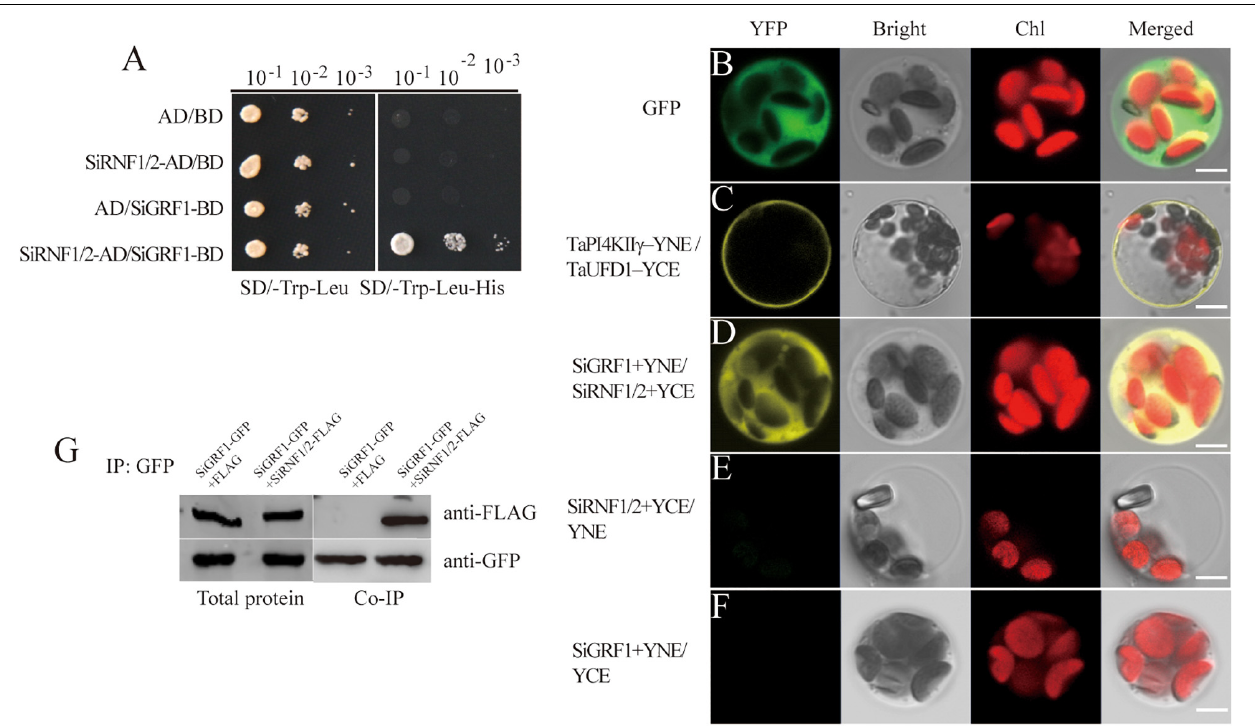
FIGURE 8 | SiGRF1 interacted with SiRNF1/2 in vivo . (A) SiGRF1 interacted with SiRNF1/2 in yeast. Yeast strains expressing construct combinations of AD/BD, SiRNF1/2-AD/BD, AD/BD-SiGRF1, and SiRNF1/2-AD/BD-SiGRF1 were grown on media minus tryptophan and leucine (left panel) or minus tryptophan, leucine and histidine (right panel). (B) Green fluorescent protein localized throughout foxtail millet leaf protoplasts. (C) TaPI4KII γ -YNE/TaUFD1-YCE was a positive control, TaPI4KII γ and TaUFD1 can interact with each other in the plasma membrane. (D) Combinations of SiGRF1-YNE and SiRNF1/2-YCE were transiently co-expressed in foxtail millet leaf protoplasts. The YFP fluorescence indicates BiFC signals. Individual and merged images of YFP and Chl autofluorescence (Chl), as well as bright-field images of protoplasts are shown. Scale bars = 5 µ m. (E) SiRNF1/2-YCE and YNE transiently co-expressed in foxtail millet leaf protoplasts. (F) SiGRF1-YNE and YCE transiently co-expressed in foxtail millet leaf protoplasts. (G) SiGRF1-SiRNF1/2 interaction analysis using Co-IP. Anti-GFP affinity gels were used for immunoprecipitation and an anti-FLAG antibody was used to detect